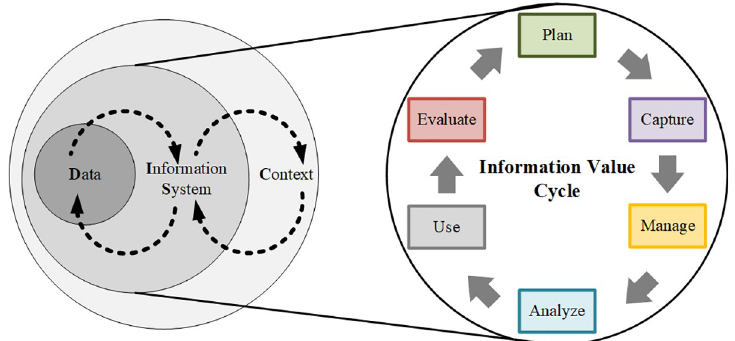
Fig 1. Information Value Cycle—Data-Information System-Context (IVC-DISC) framework for contextual analysis matrix [26].